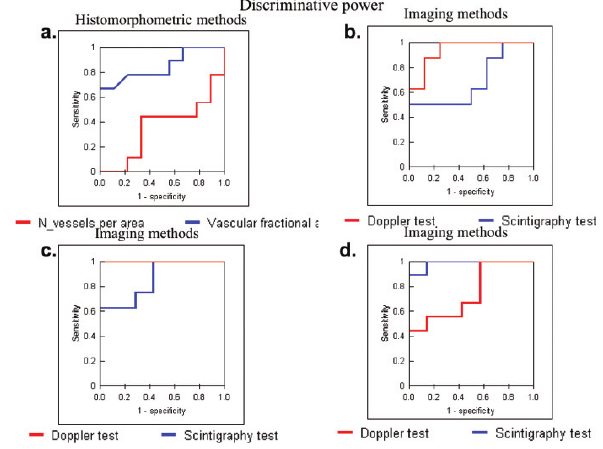
Figure 4 - Areas under the curve (AUC) of measurements for individual methods of imaging or histomorphometry to discriminate the operative status of the hips are shown. Caption A shows a larger AUC for fractional vascular area (AUC=0.846 ± 0.099) compared with number of vessels/mm 2 (AUC=0.358 ± 0.141), however caption B reveals no significant differences in AUCs between number of pixels of power Doppler (AUC=0.938 ± 0.058) and scintigraphy (AUC=0.688 ± 0.146). For discrimination between epiphyses presenting with large (% of vessels >11) or small vascular spaces (% of vessels ≤ 11) power Doppler performed slightly better (AUC=0.99) than scintigraphy (AUC=0.857 ± 0.099) (C). On the other hand, for discrimination between highly (number of vessels/mm 2 >7.8) and poorly (number of vessels/mm 2 ≤ 7.8) vascularized epiphyses scintigraphy (AUC=0.984 ± 0.022) performed better than power Doppler sonography (AUC=0.746 ± 0.131)